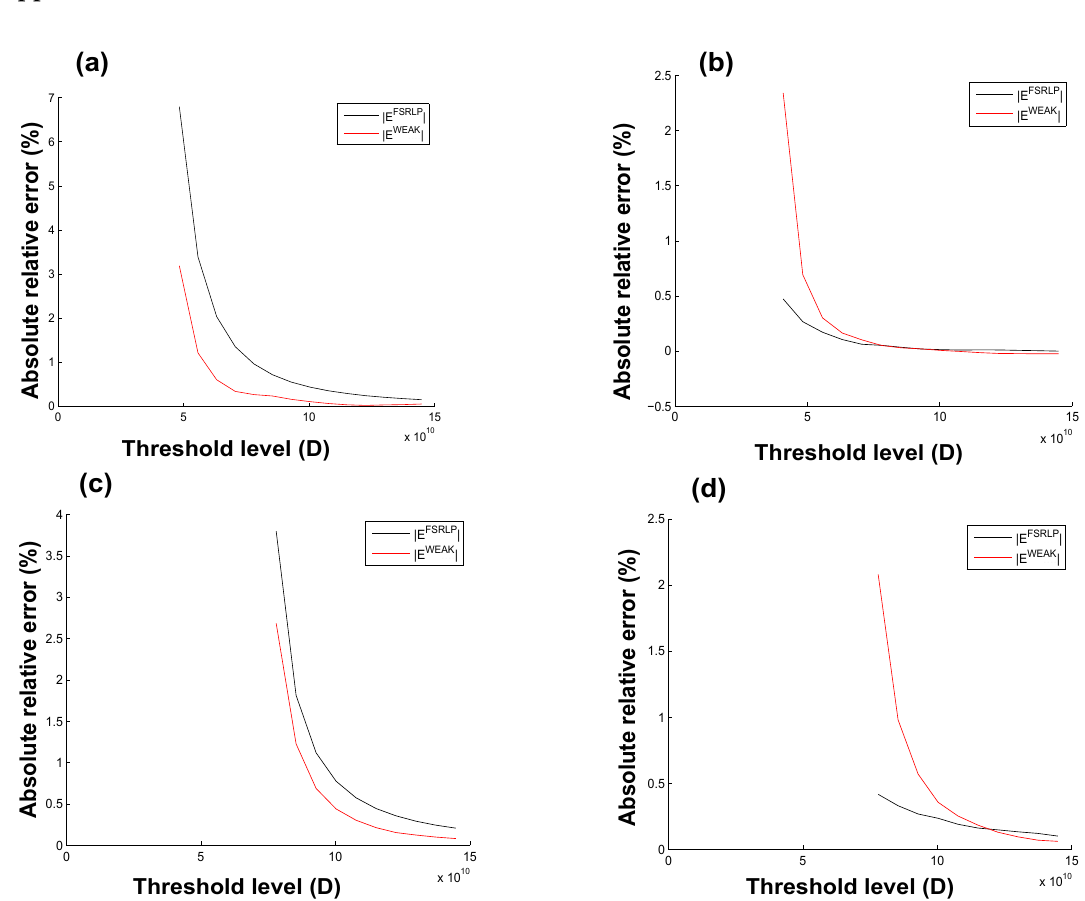
Figure A3. Absolute relative error comparisons for each severity distribution, for: ( a ) GP distributed losses in the ZCB case (and the CP case in ( b )); and ( c ) Burr distributed losses in the index-linked ZC CAT bond case (and the index-linked CP CAT bond case in ( d )), for T = 1 year. Note the different threshold levels, for each severity distribution, from which the weak approximation became